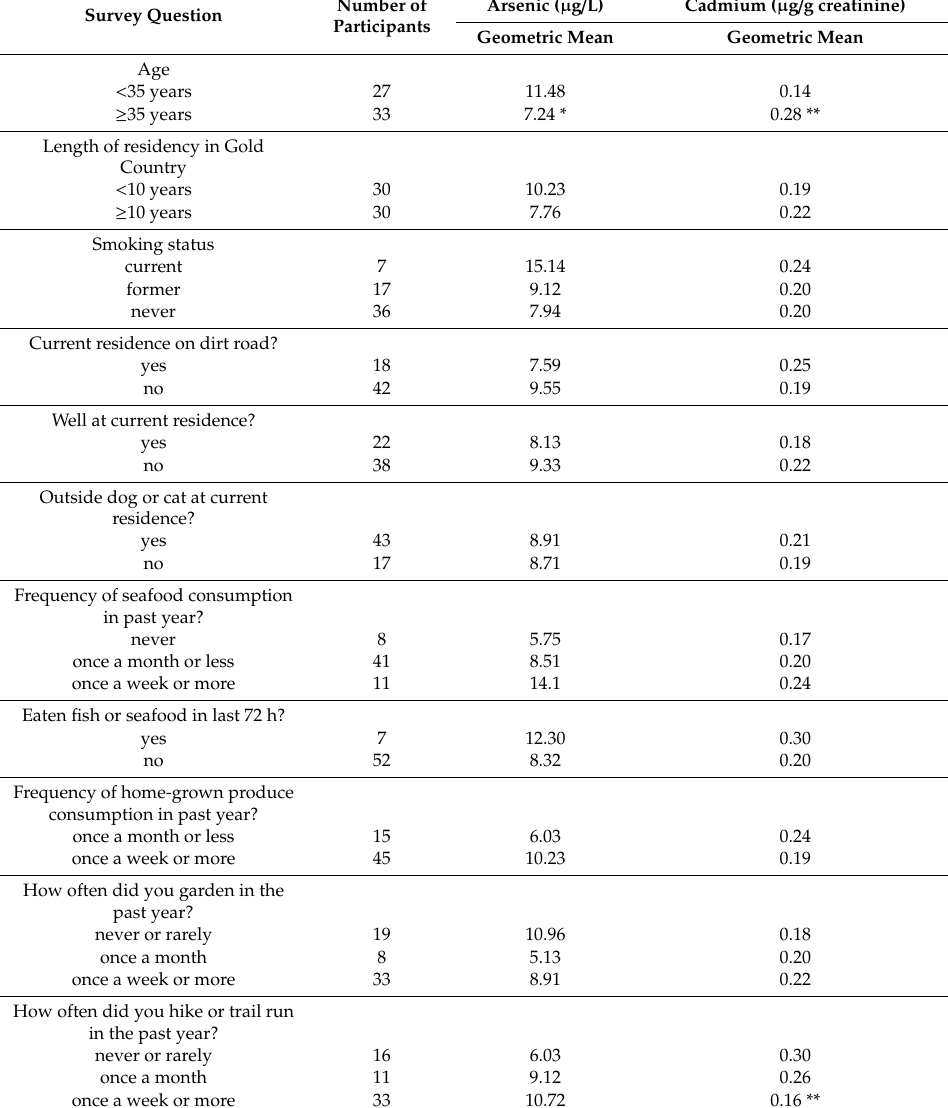
Table 3. Urinary arsenic and cadmium levels versus answers to survey questions on residential features, diet, and activities.